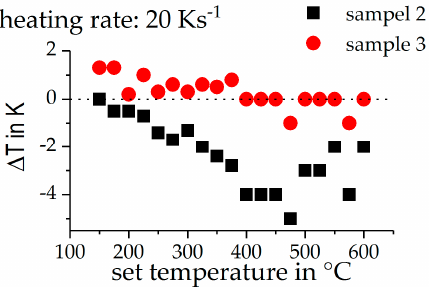
Figure 7. Deviation of the maximum temperature of the unregulated samples from the target